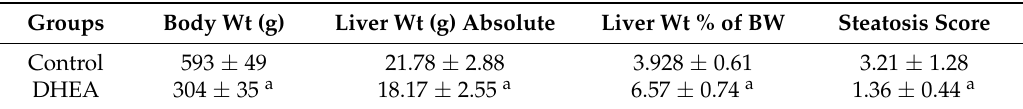
Table 1. Body weight (BW, g), liver weight (absolute and as % of body weight), and steatosis score (mean ±